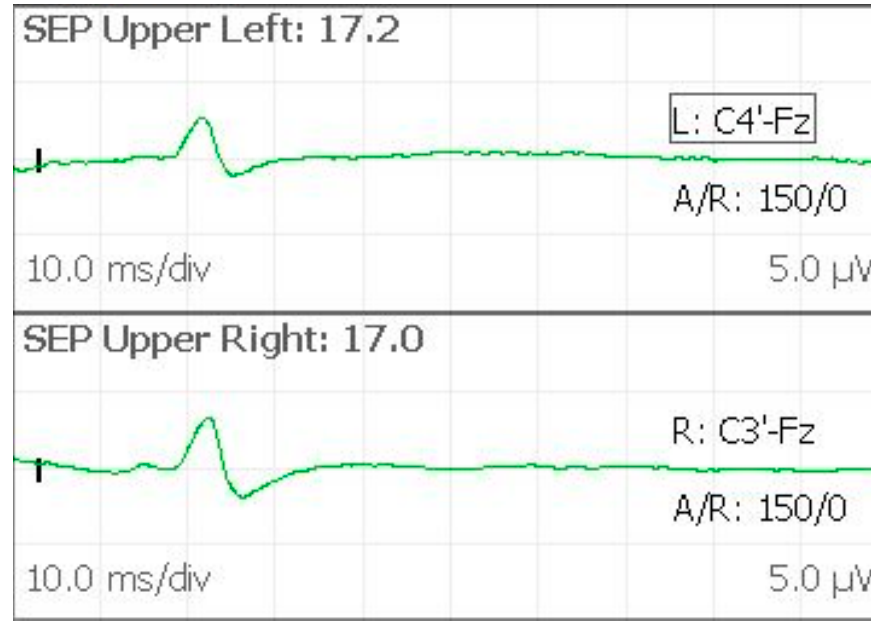
Figure 5. SEPs evoked from upper limbs, with the N20 peak symmetrically observed.